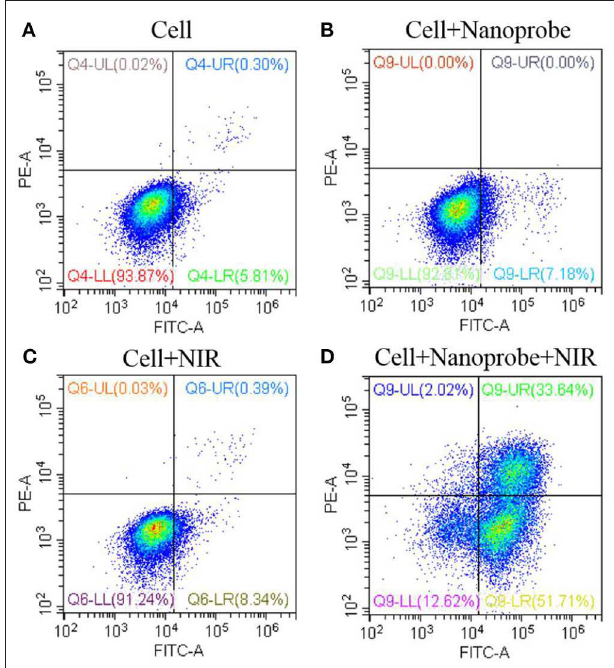
FIGURE 8 | Cell viability (%) of the UCNPs@SiO 2 /HA/MB/ICG@PEG-TPP nanotheranostic agent treated with (A) PBS, (B) nanoprobe, (C) NIR irradiation, (D) nanoprobe and NIR